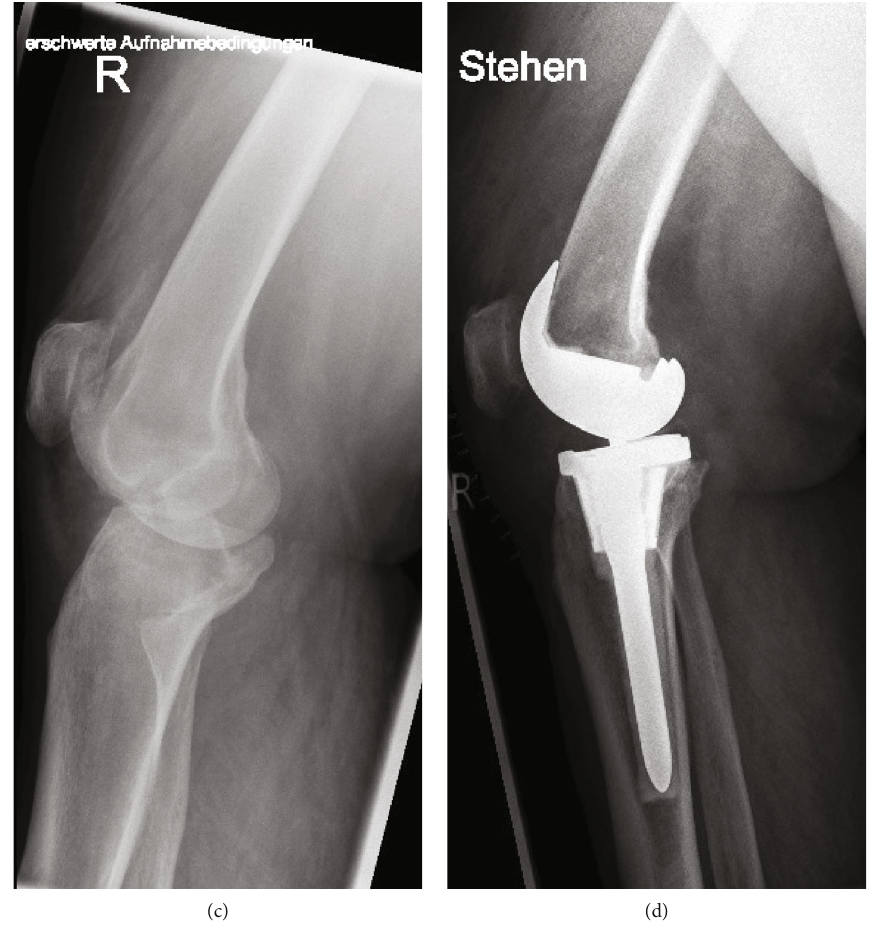
Figure 3: Gonarthritis IV ° and completely impacted medial tibial plateau with small di ff use bony remains (a, c). Postoperative standing antero-posterior and lateral X-ray of the right knee. Pay attention to the asymmetric tibial cone which reconstructs the medial tibial plateau (b,